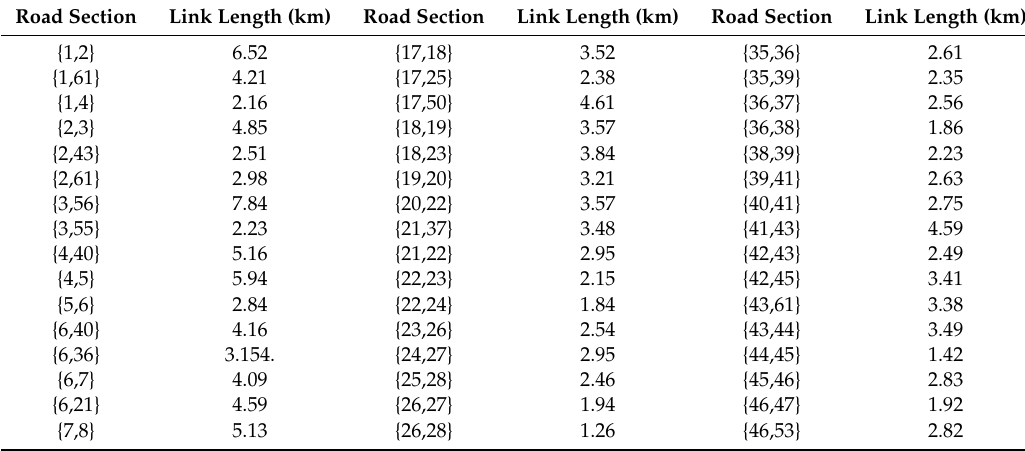
Table A3. Network segment length